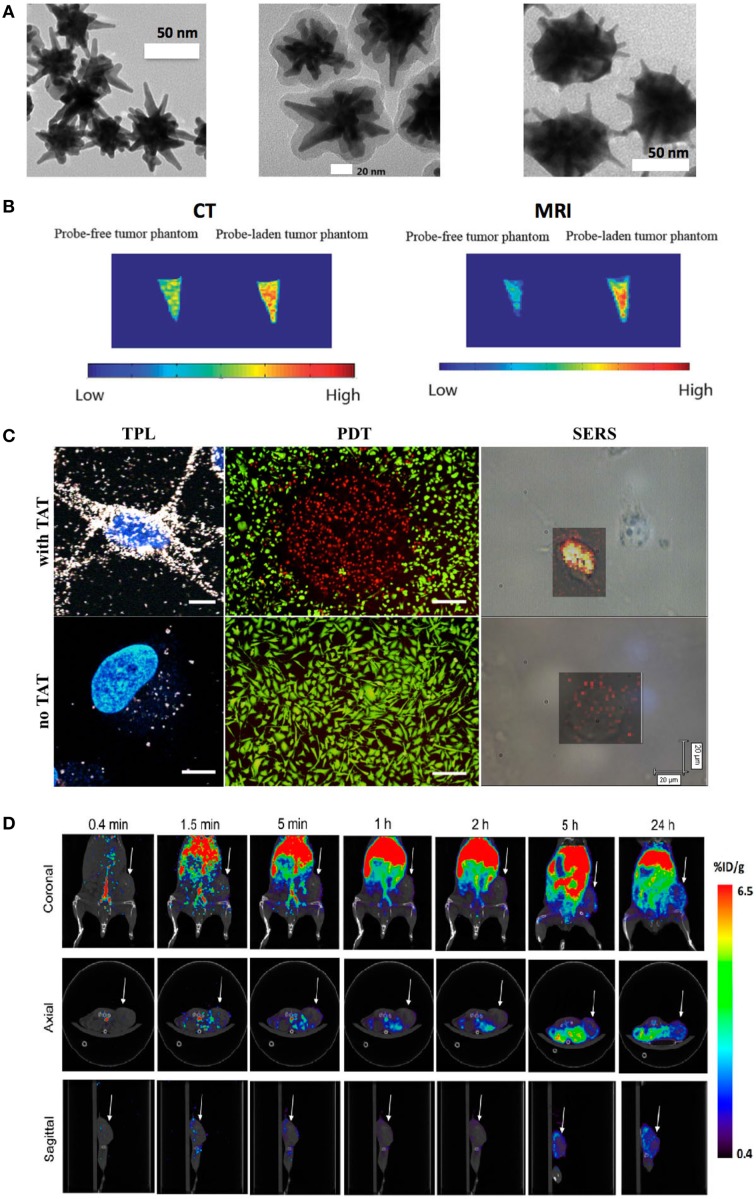
(A) TEM images of synthesized AuNS (left), silica-coated AuNS (middle), and silver coated-AuNS (right). (B) CT (left) and MRI (right) imaging with developed multifunctional AuNS nanoprobe. (C) Demonstration of TAT-peptide enhanced TPL imaging, photodynamic therapy (PDT), and surface-enhanced Raman scattering (SERS) imaging after 1-h incubation with the AuNS probe. Scale bars for TPL, PDT and SERS image are 10, 250, and 20 μm, respectively. (D) PET/CT imaging with 64Cu labeled AuNS probe, which was injected intravenously through tail vein. Dynamic imaging at various time pointes were acquired. Arrow shows tumor (Fales et al., 2011, 2013, 2014; Yuan et al., 2013a; Liu et al., 2015b).